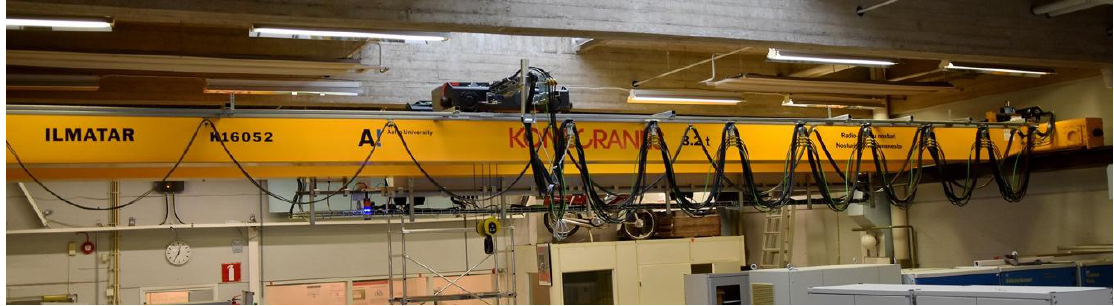
Figure 2. The Industrial Internet overhead crane used in the research.